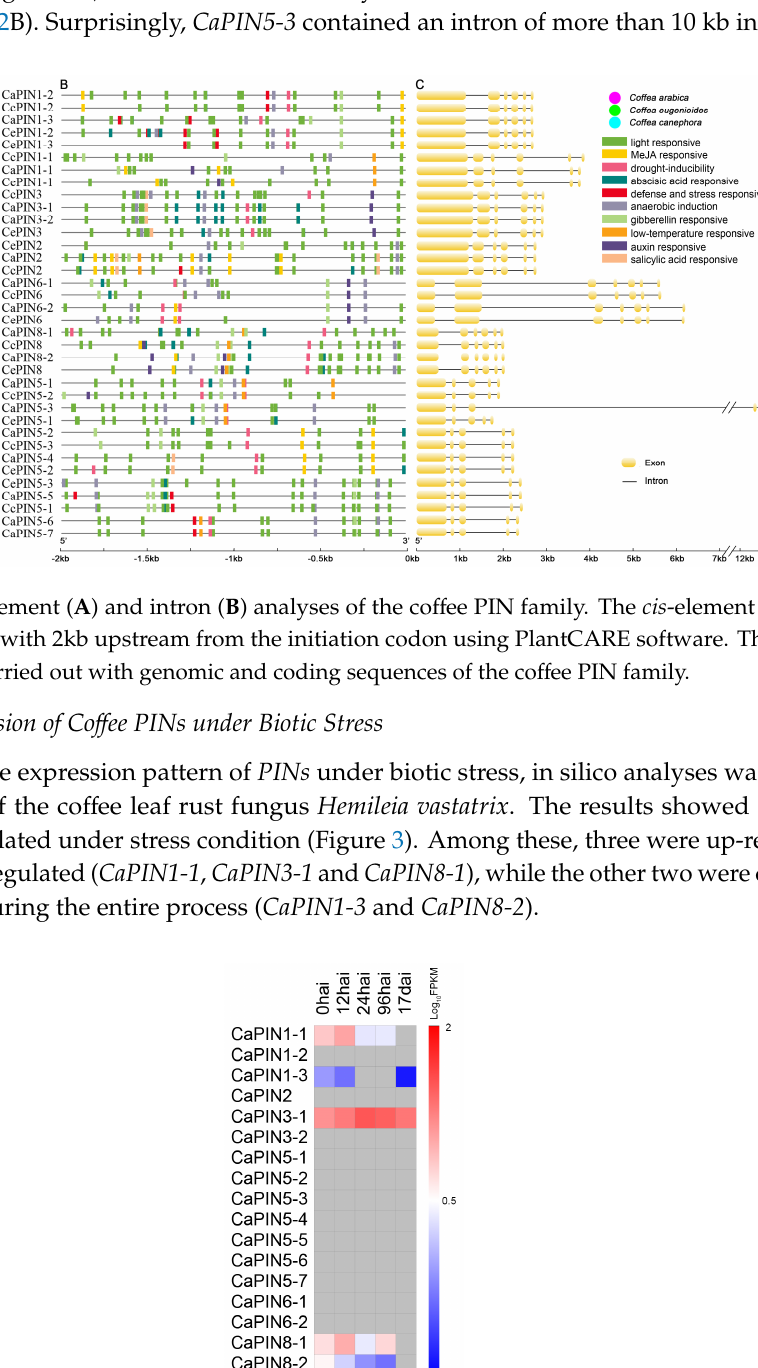
Figure 3. In silico expression of PINs in the leaf of C. arabica after inoculation with the coffee leaf rust fungus Hemileia vastatrix . Hai and dai represent hours and days after inoculation, respectively. Grey squares represent no data.